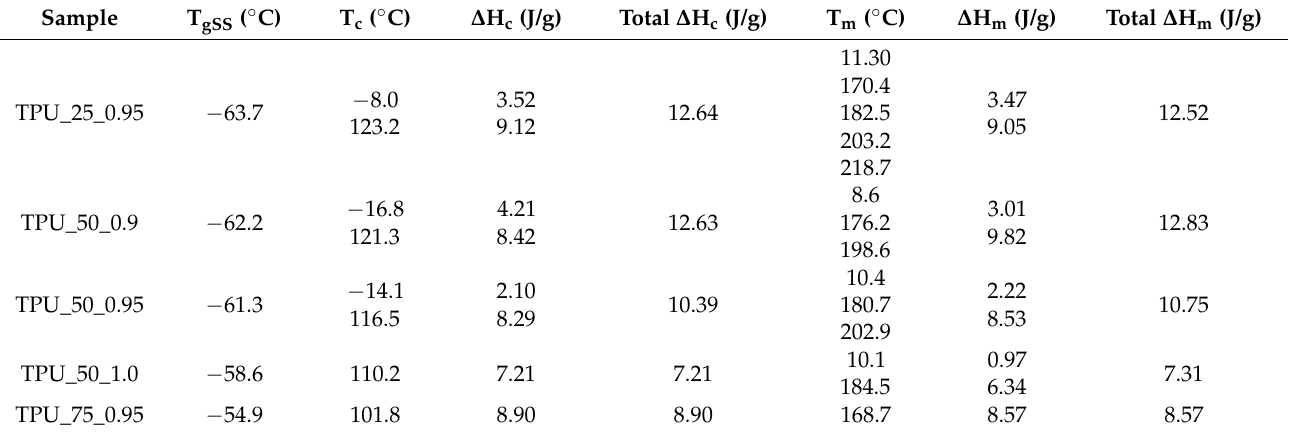
Table 3. Thermal properties of synthesized TPUs determined by DSC technique.